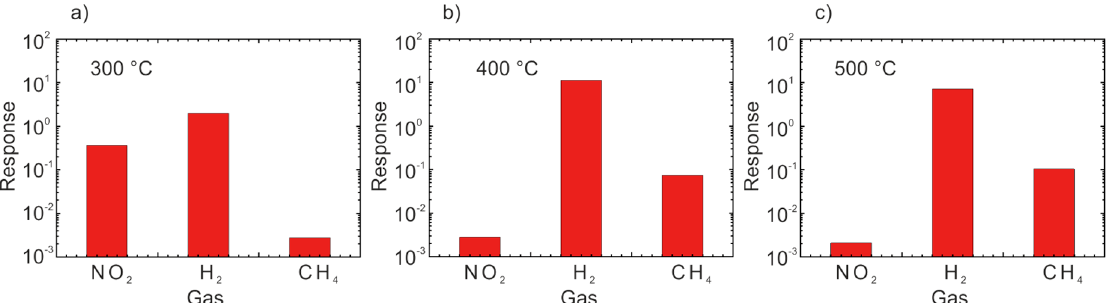
Figure 3. Response towards nitrogen dioxide, hydrogen and methane at 1 ppm, 1000 ppm, 50 ppm respectively and working the temperature of 300 °C ( a ), 400 °C ( b ), 500 °C ( c ) and RH 40% at the environmental temperature of 20 °C. Reprint from [38], copyright (2015), with permission from Elsevier.